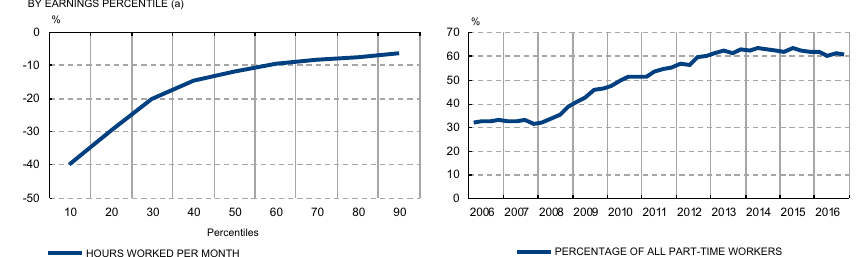
Fig. 8 Changes in hours worked 2006–2014. a. Annual gross earnings percentiles, deflated by the CPI. The average number of hours corresponds to October, which is the EES reference month. Source :